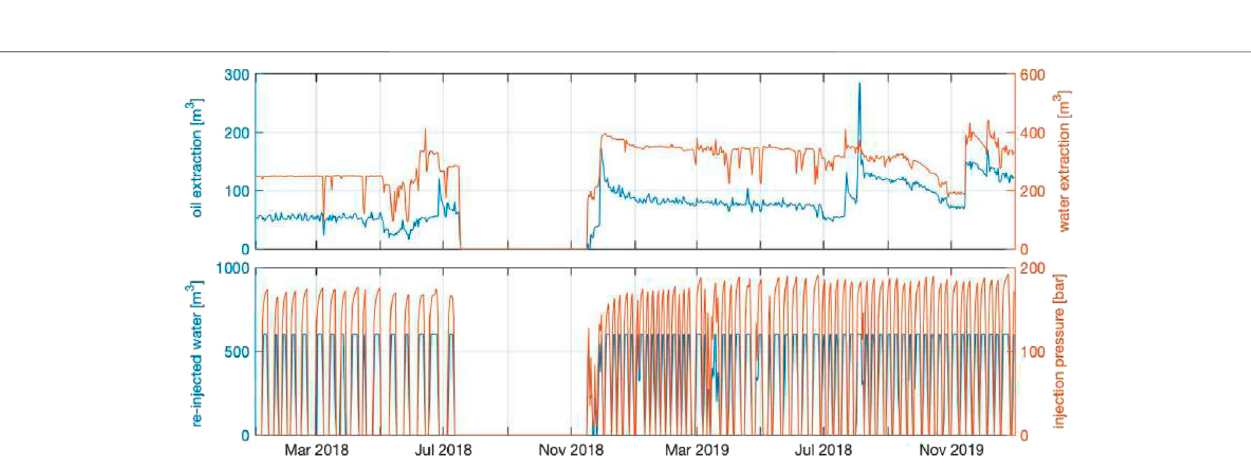
Frontiers in Earth Science |